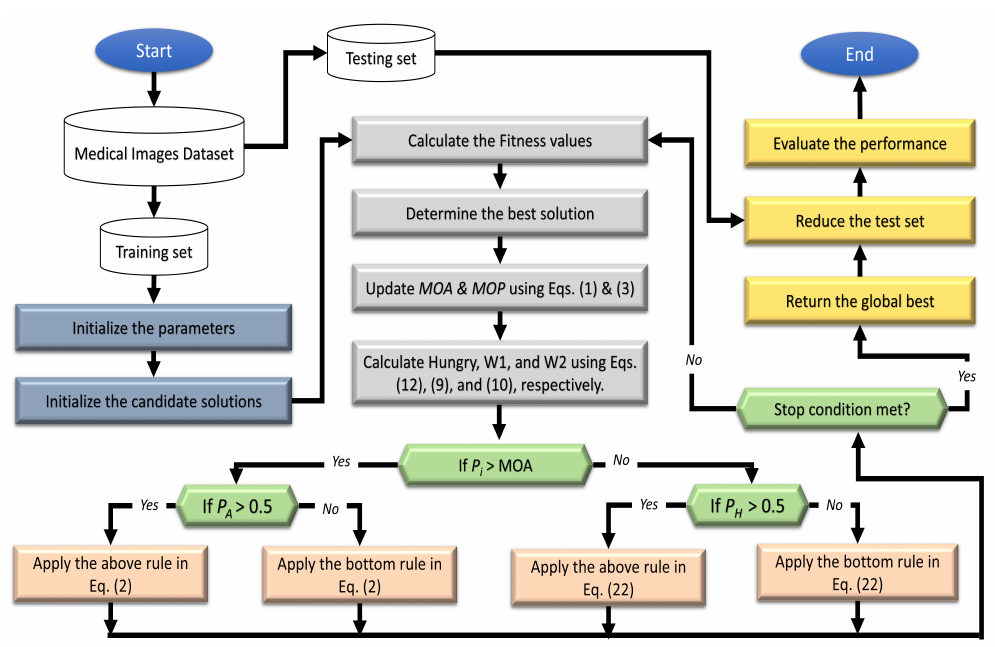
Figure 1. Flowchart showing the developed FS